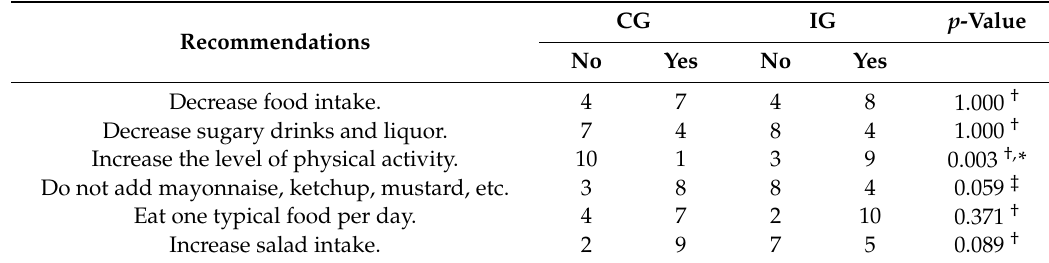
Table 2. Adherence to recommendations after the NH.